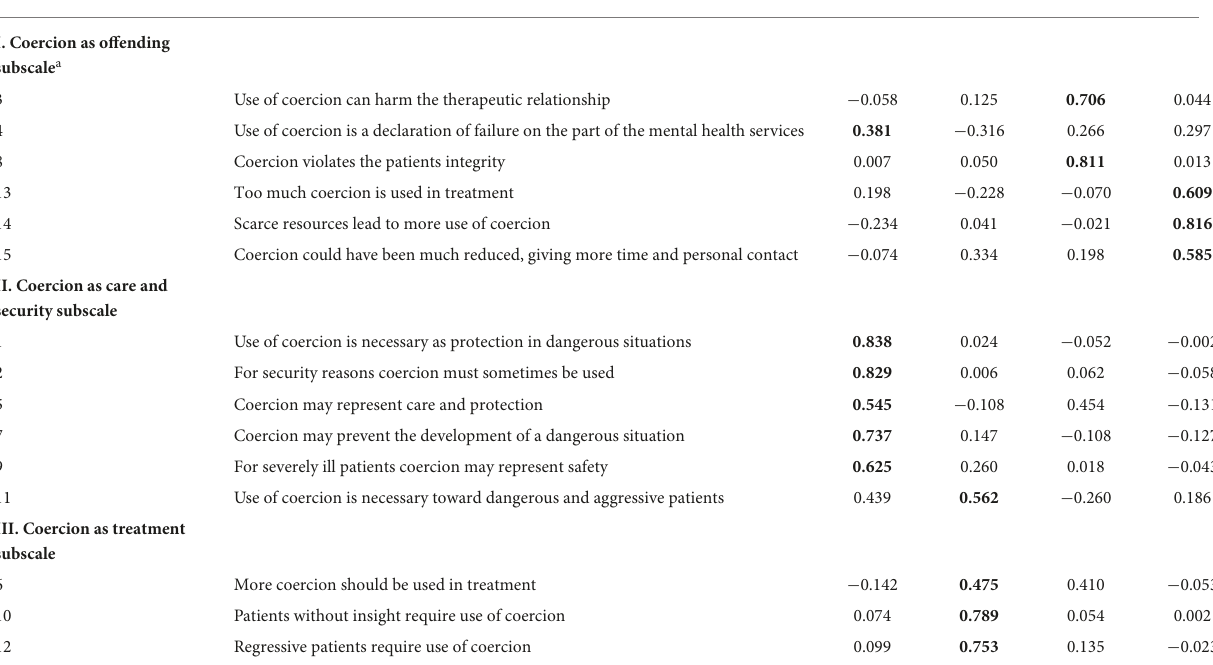
TABLE 3 Factor loadings of SACS items based on exploratory factor analysis ( N = 261).